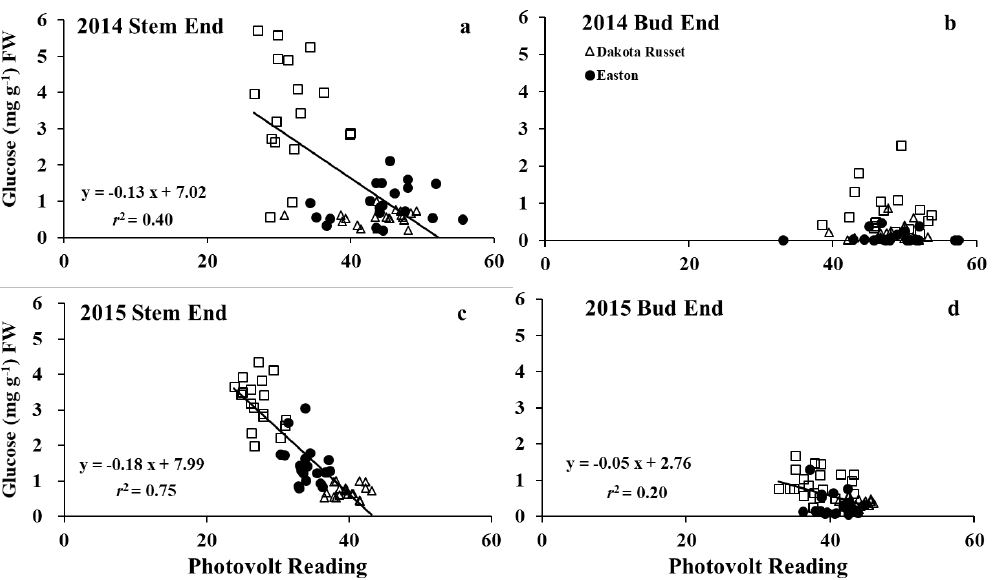
Figure 10. Relationships between tuber glucose and fry color at stem ( a , c ) and bud end ( b , d ) of French fries from tubers stored for 16 weeks at 7.8 ◦ C in 2014 and 2015.